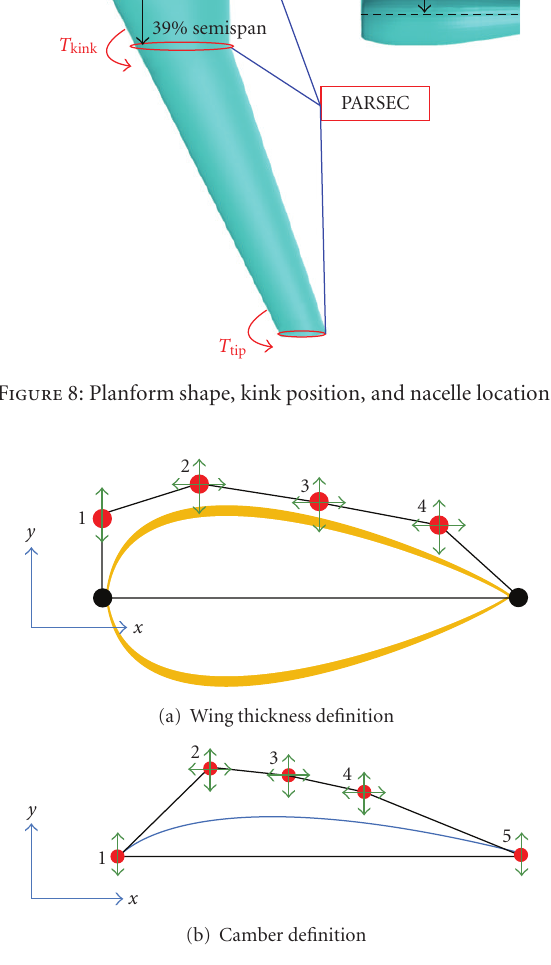
Figure 9: Pylon shape